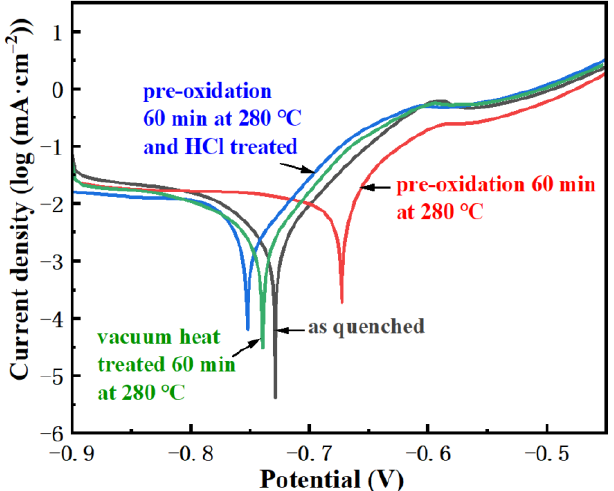
Figure 6. The polarization curve of the sample after removing the surface oxide layer.